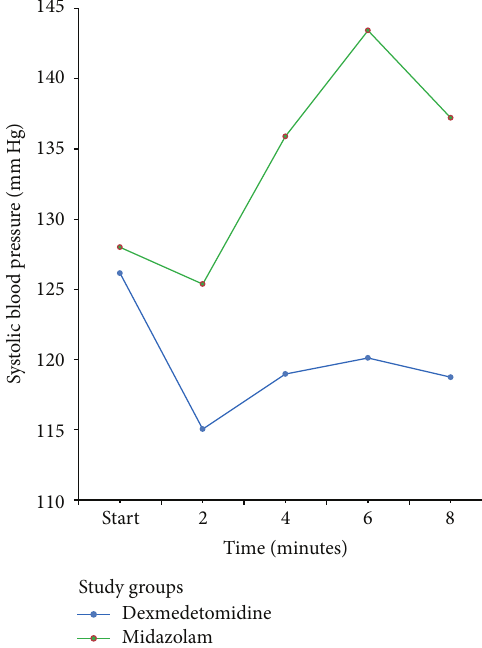
Figure 1: Systolic blood pressure in relation to